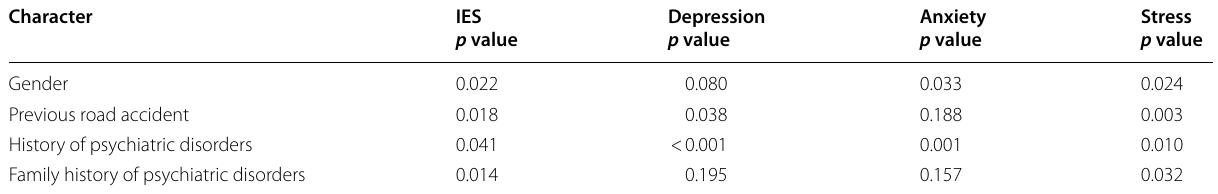
Table 5 Univariate linear regression analysis